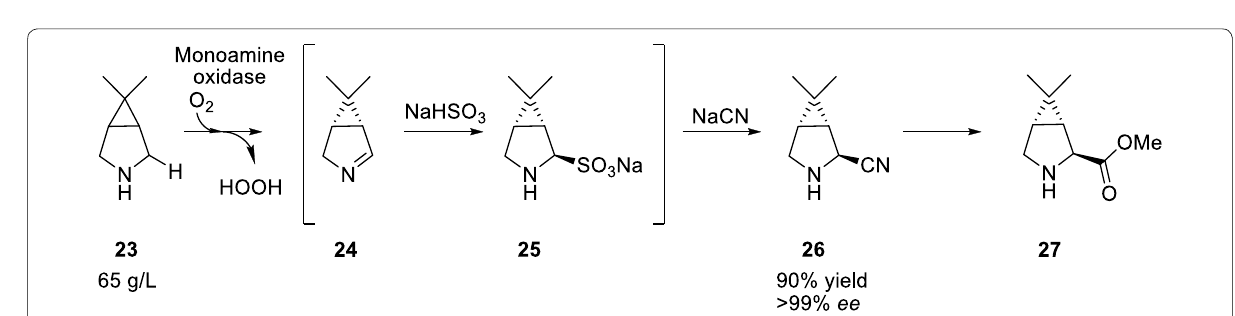
Fig. 8 The Merck/Codexis process for manufacturing a Boceprevir intermediate based on amine oxidase-catalyzed